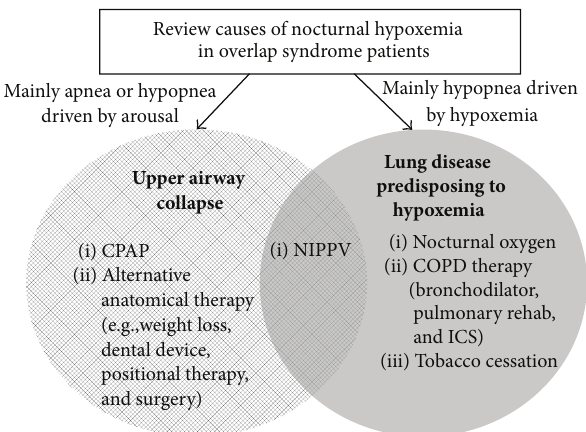
Figure 2: Treatment options for patients with COPD and OSA overlap syndrome. CPAP: continuous positive airway pressure; NIPPV: nasal intermittent positivepressureventilation; ICS:inhaled